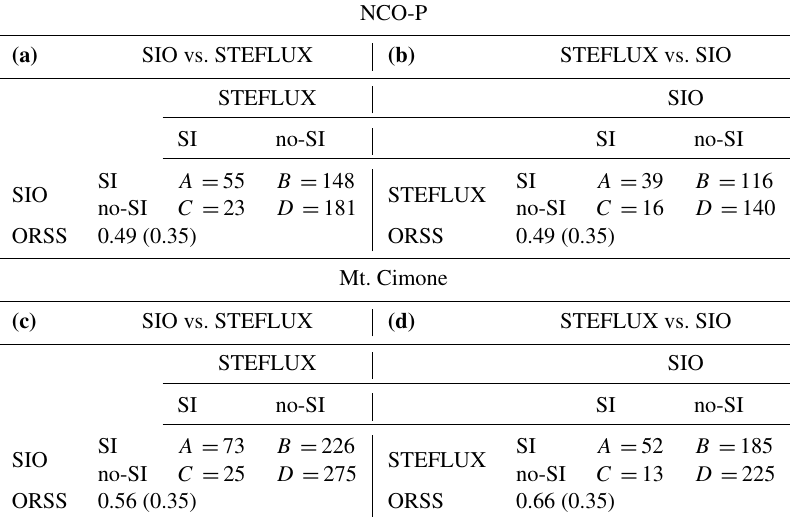
Table 2. The 2 × 2 contingency tables for the comparisons of the SI event time series, i.e., identified by the SIO and STEFLUX approaches, for NCO-P (a, b) and Mt. Cimone (c, d) . For each table the odds ratio skill score (ORSS) is also reported, along with the minimum ORSS required to have real skill at the 99% confidence level (in parentheses; see Thornes and Stephenson, 2001). Capital letters are defined as follows: A indicates the number of SI events selected by both methodologies (STEFLUX and SIO), B represents the number of events selected as SI by the first methodology but as no-SI by the second one, C represents the number of events selected as no-SI by the first methodology but as SI by the second one, and D represents the number of no-SI events selected by both methodologies.